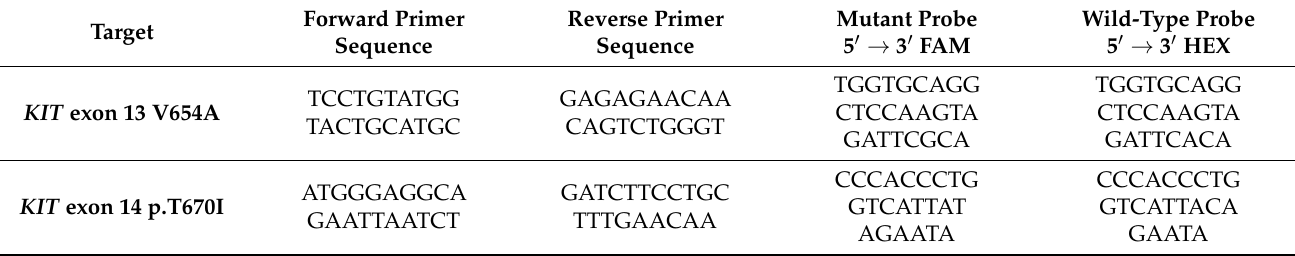
Table 1. ddPCR primer and probe sequences used for